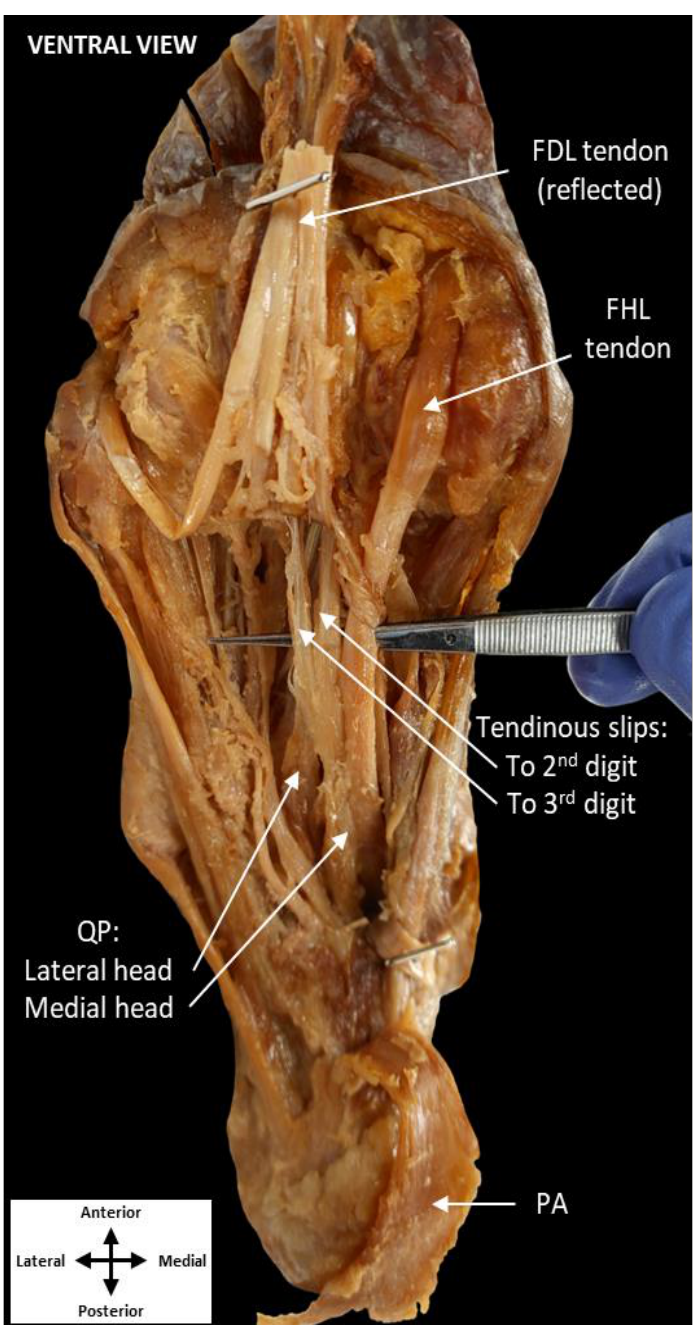
Figure 2. Reflection of the tendon of FDL and tendinous slips. Two tendinous slips were observed inserting along the second (1st slip) and third (2nd slip) digits. These slips are separate from the tendon of FDL (reflected), FHL, and the lumbricals. Additionally, a portion of the medial head of QP inserts on the tendon of FHL, while the lateral head of QP inserts on the tendinous slip to the third digit. (plantar aponeurosis: PA, flexor digitorum longus: FDL, quadratus plantae: QP, flexor hallucis longus: FHL).